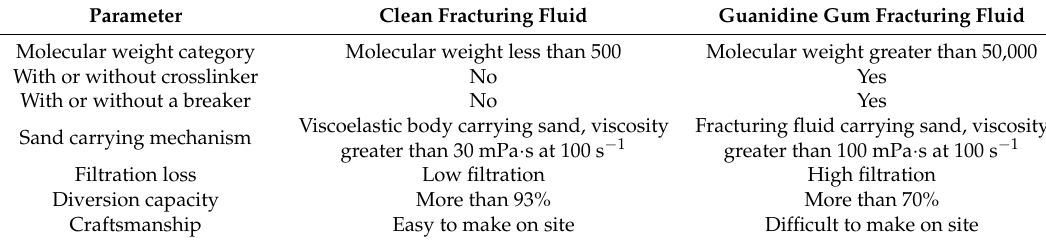
Table 1. Comparison of clean fracturing fluid and guanidine gum fracturing